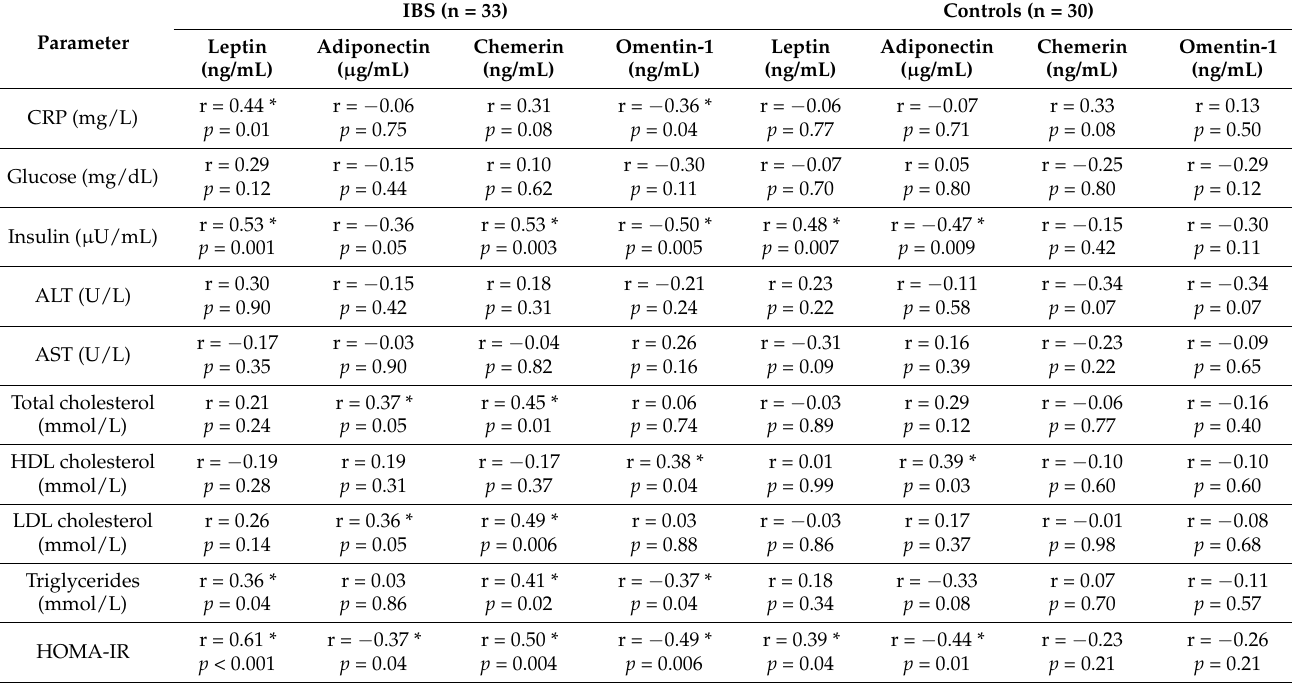
Table 3. Analysis of correlations between examined adipokines and laboratory